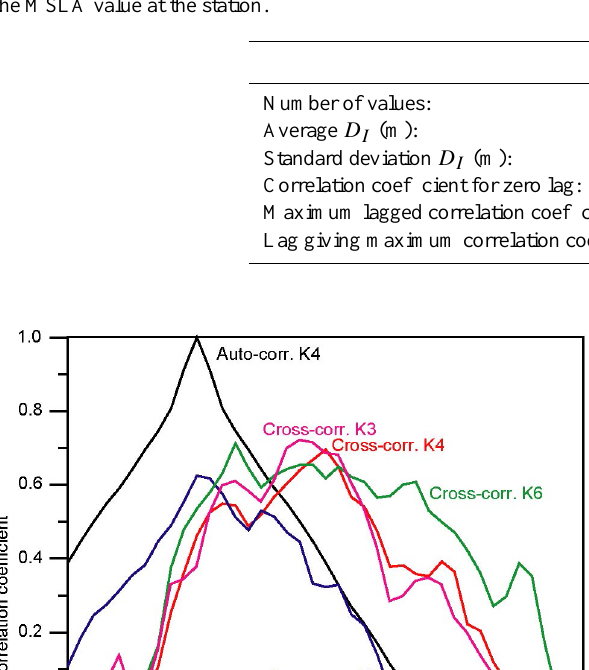
Table 1. Characteristics of the interface depth ( D I ) at each of the deep standard stations on the K-section and its correlation coefficient with the MSLA value at the station.